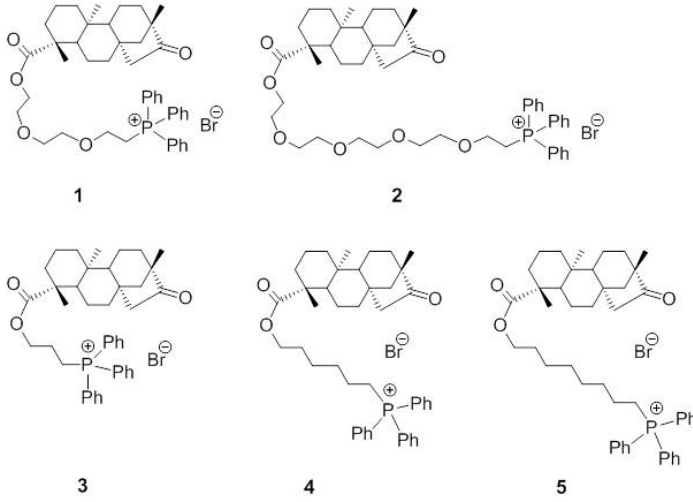
Figure 6. Chemical structure of triphenylphosphonium (triPP)-conjugated derivatives of isosteviol.